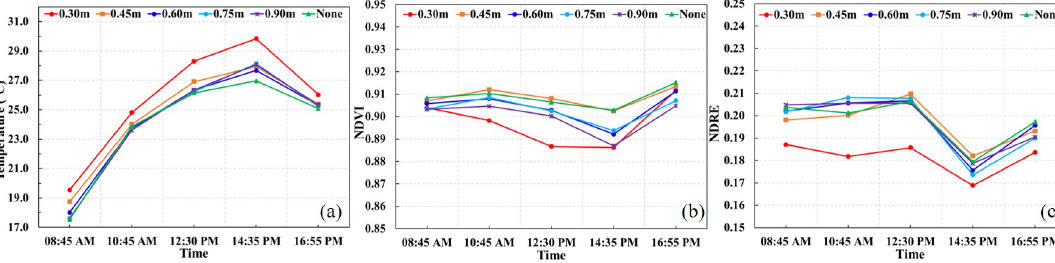
Figure 12. Diurnal change of canopy temperature, NDVI and NDRE with different water treatment and time of the day with 0.6 m and 0. 9 m treatments in the mid-morning (10:45 pm). Average NDVI of each rooting depth was significantly am), and with 0.75m and control in the late afternoon (16:55 different in three UAV diurnal data collections at 10:45